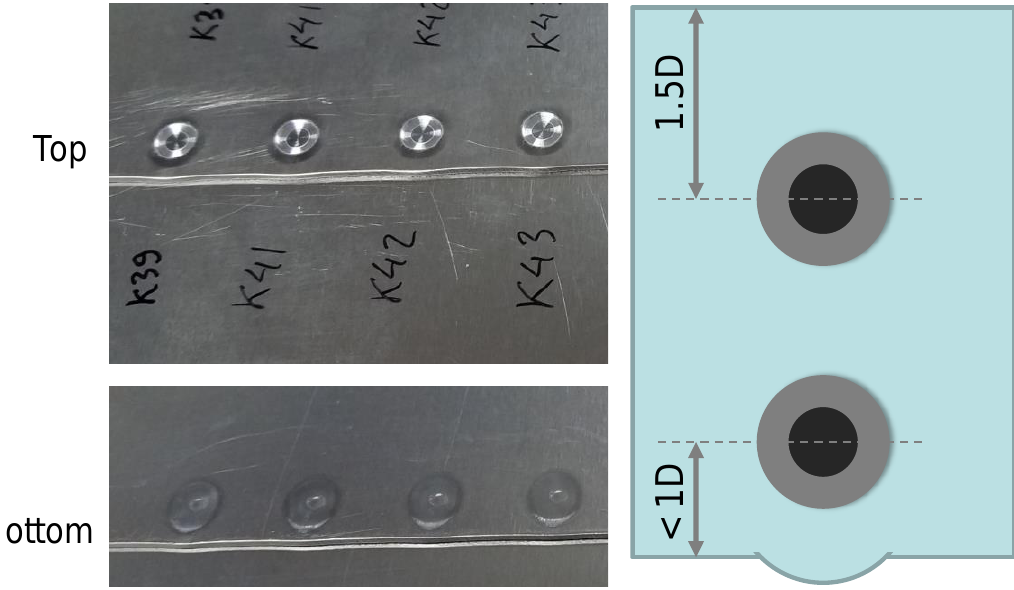
Figure 9. Edge swelling exhibited by 1D-edge-margin panels during the RFSSW process. Larger edge margin panels did not exhibit edge swelling. D (=7 mm) is the spot weld diameter.